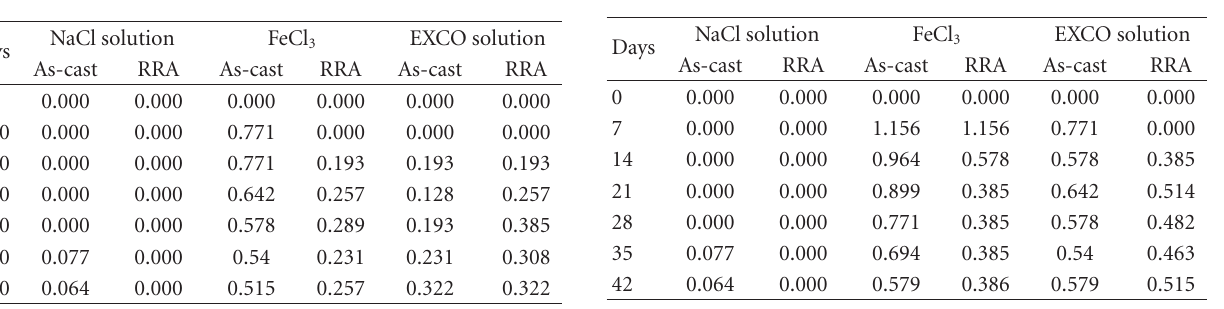
Table 5: Gravimetric corrosion rate (mm/yr) for the 1.51% Mg